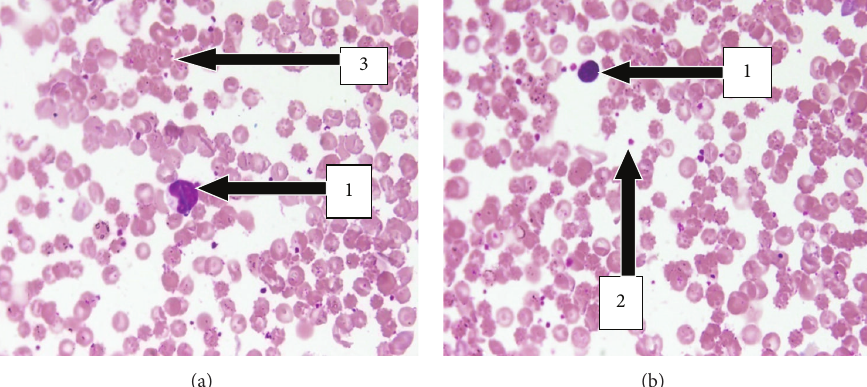
Figure 1: Leishman stained peripheral blood smear plate (20x). (a) Peripheral blood smear plate of control male SD rats showing normal distribution of blood cells. Note the white blood cell (1) , platelet (2) , and red blood cell (3) . (b) Peripheral blood smear plate of treated animals of dose 2000 mg/kg showing normal distribution of WBCs, RBCs, and platelets. Note the normocytic and normochromic nature of the